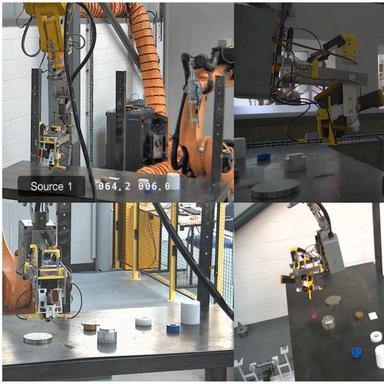
Control room views of LIBS deployed within the simulated hot cell, identifying samples on the sorting table.